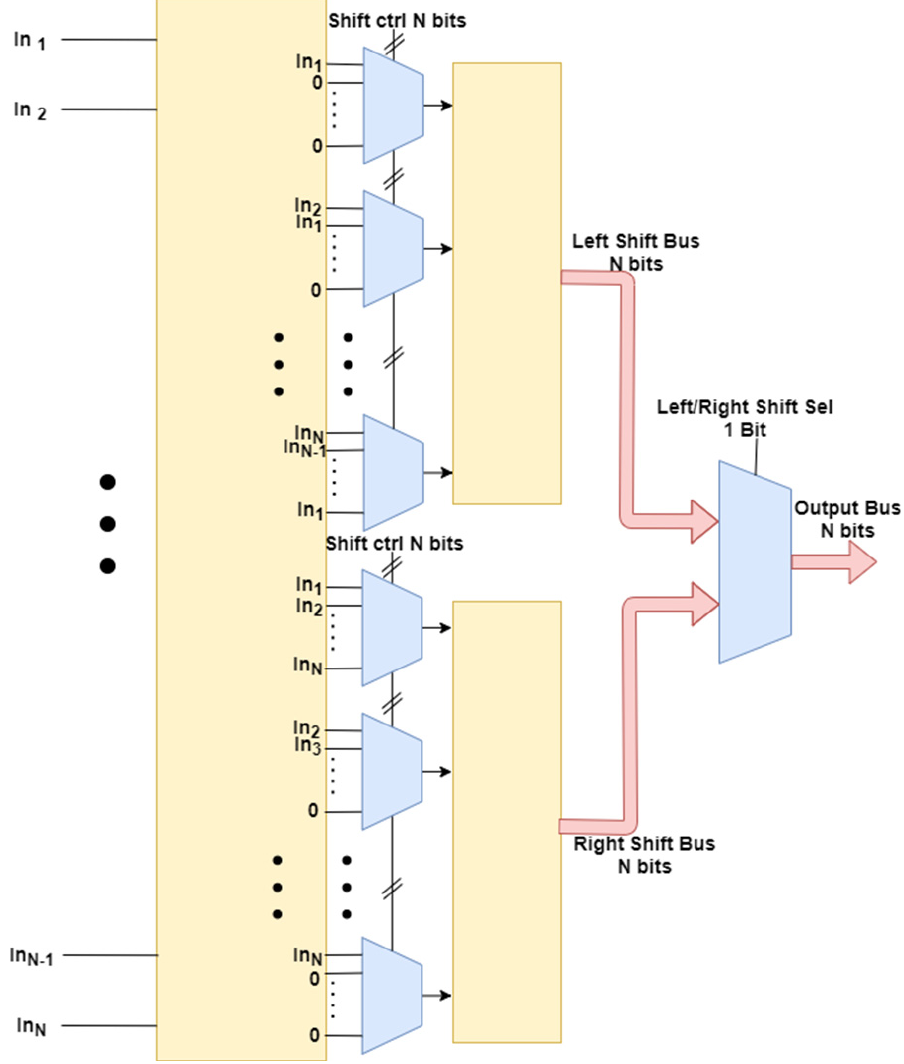
Figure 8. Compact block-level description of the Shift Controller module, which applies a number of logical left/right displacements to the N input lines In 1 …In N equal to the number given by the Shift Ctrl bits. The yellow blocks hide routing of interconnection lines between the modules (not shown for clarity).